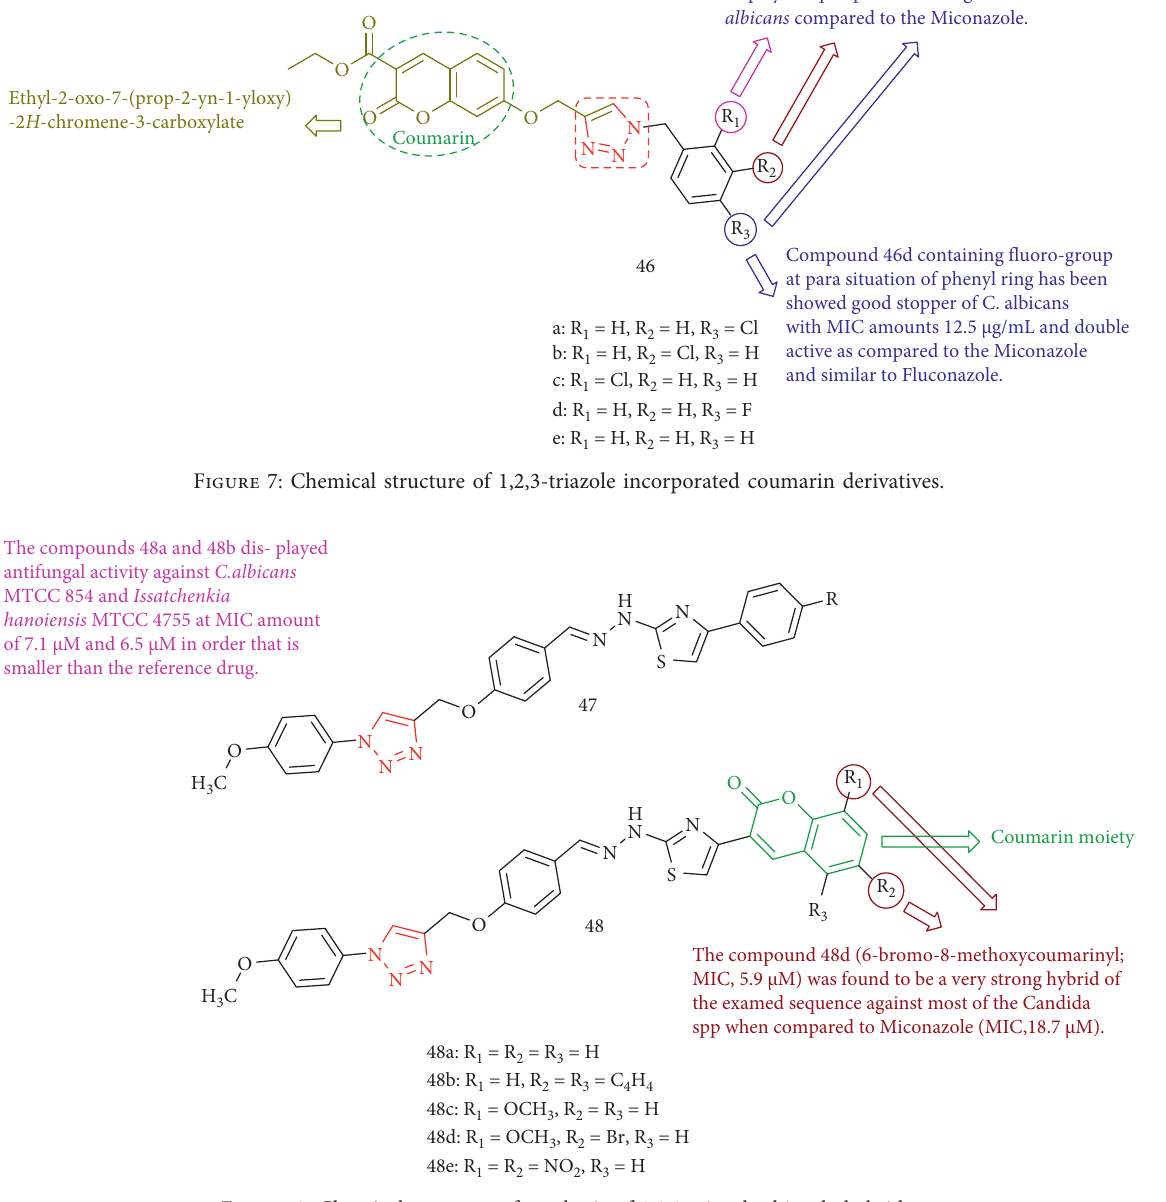
Figure 8: Chemical structure of synthesis of 1,2,3-triazole-thiazole